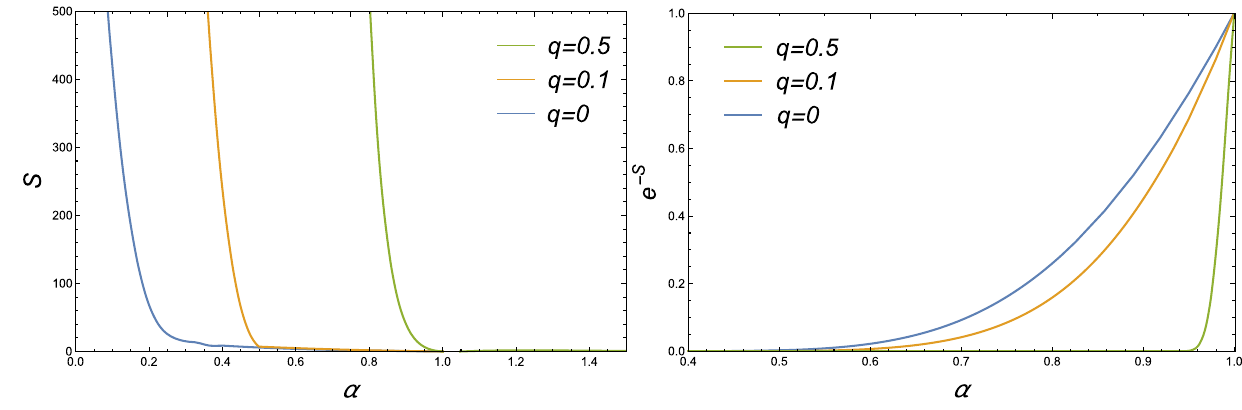
Fig. 6 The classical string action and its exponential behavior versus α in the D(-1)–D3